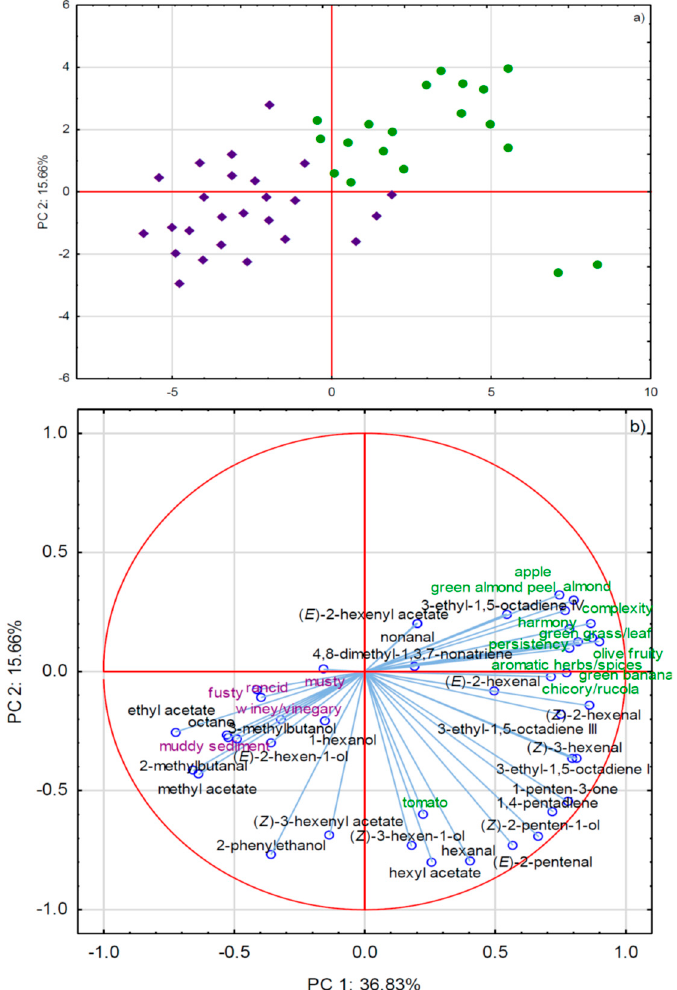
Figure 2. ( a ) Separation of olive oil samples sold as extra virgin olive oil (EVOO) in Italy according to the origin of purchase by the first two principal components, PC1 and PC2. Green cycles represent monovarietal PDO EVOO purchased on family farms, while violet rhombs represent commercial-blended EVOO purchased in supermarkets. ( b ) Factor loadings of selected variables, i.e., concentrations of volatile aroma compounds and intensities of sensory attributes, obtained by GC-MS and sensory analyses, respectively, on PC1 and PC2.